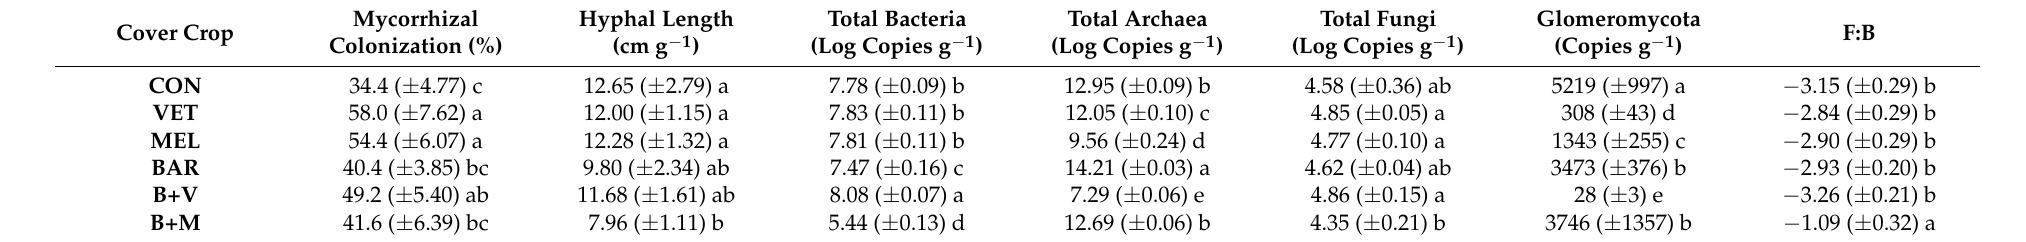
Table 2. Microbiological variables in maize crop after the different cover